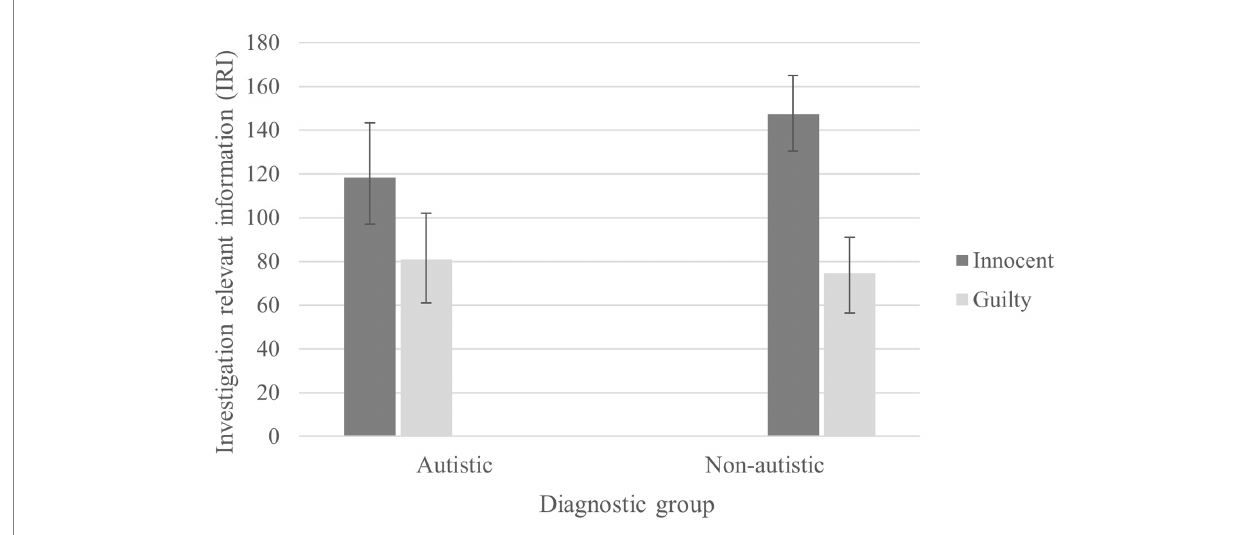
FIGURE 4 Mean IRI scores for autistic and non-autistic groups in innocent and guilty conditions (with BCa 95% confidence error